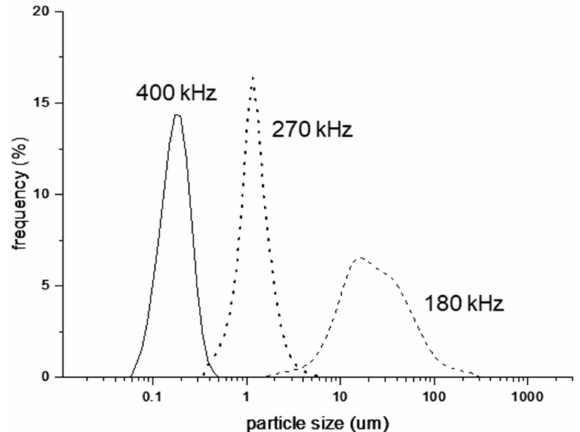
Figure 3. Size distribution of oil particles produced at different frequencies using the focused